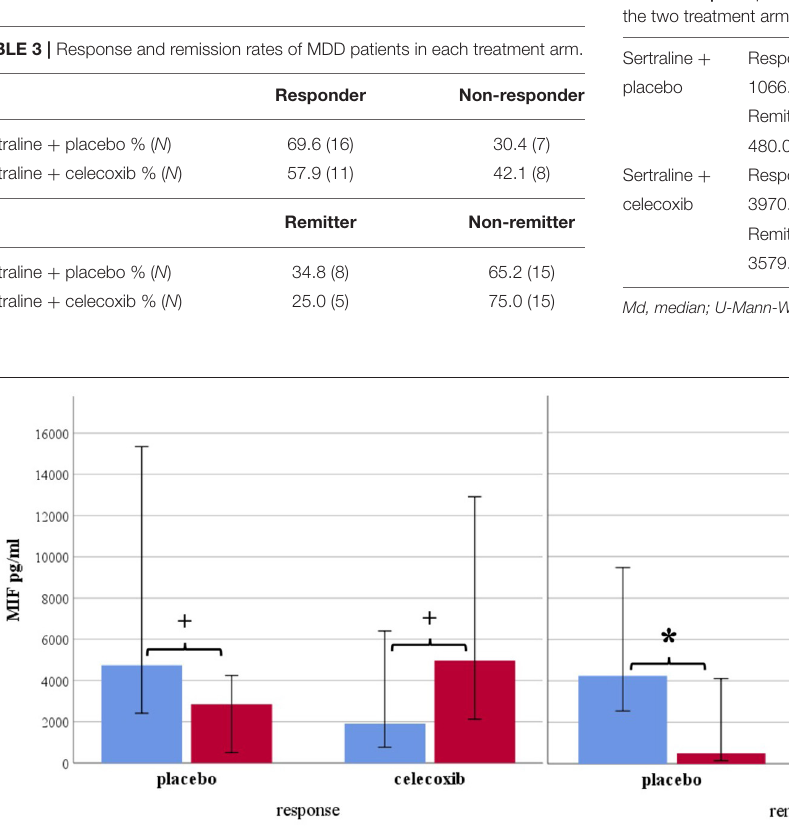
Frontiers in Psychiatry |